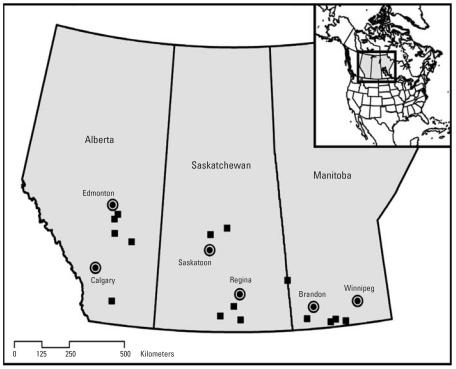
Study area showing the locations of drinking water reservoirs in Manitoba, Saskatchewan, and Alberta, Canada.